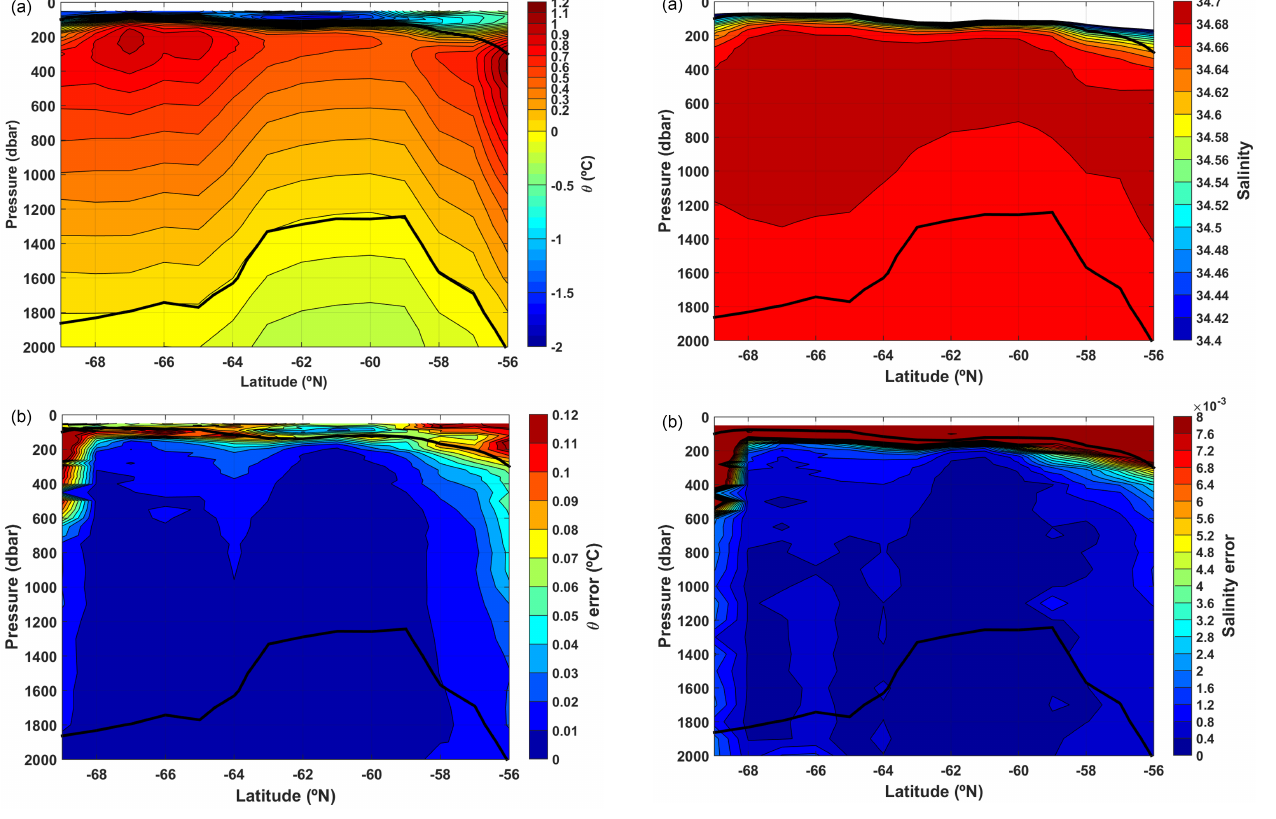
Figure 29. Potential temperature ( ◦ C) (a) and mapping error ( ◦ C) (b) for a section from 56 ◦ S to the coast along the Prime Meridian. The sections consist of the mean of the two grid cell sections adja- cent to 0 ◦ E. The thick black lines show the upper and lower bound- aries of WDW, i.e. the neutral densities of 28.0 and 28.27kgm − 3 respectively.